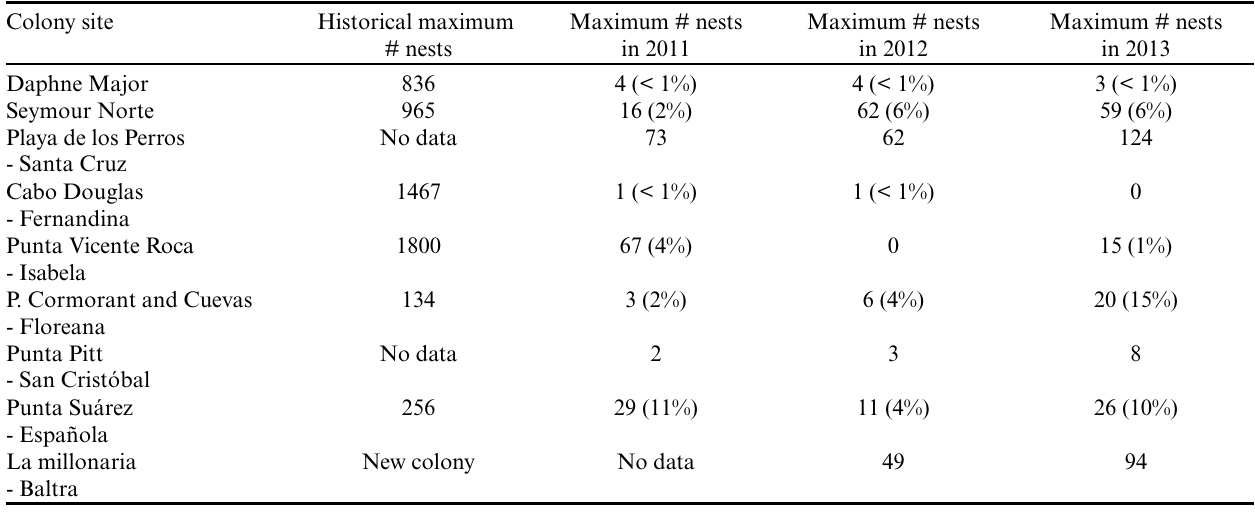
Table 2 . Blue-footed Booby ( Sula nebouxii excisa ) breeding activity at colonies in Galápagos in 2011, 2012, and 2013 in relation to historical